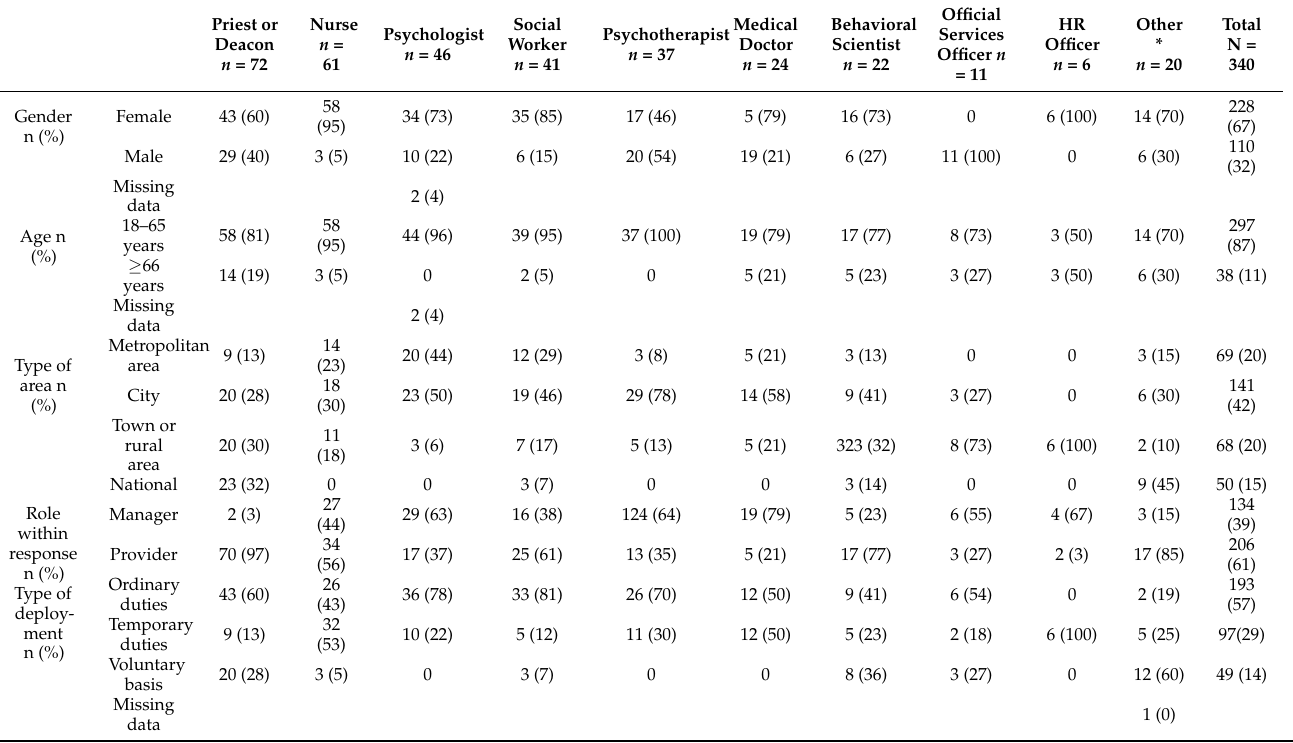
Table 1. Overview of demographics, type of deployment and previous experiences.